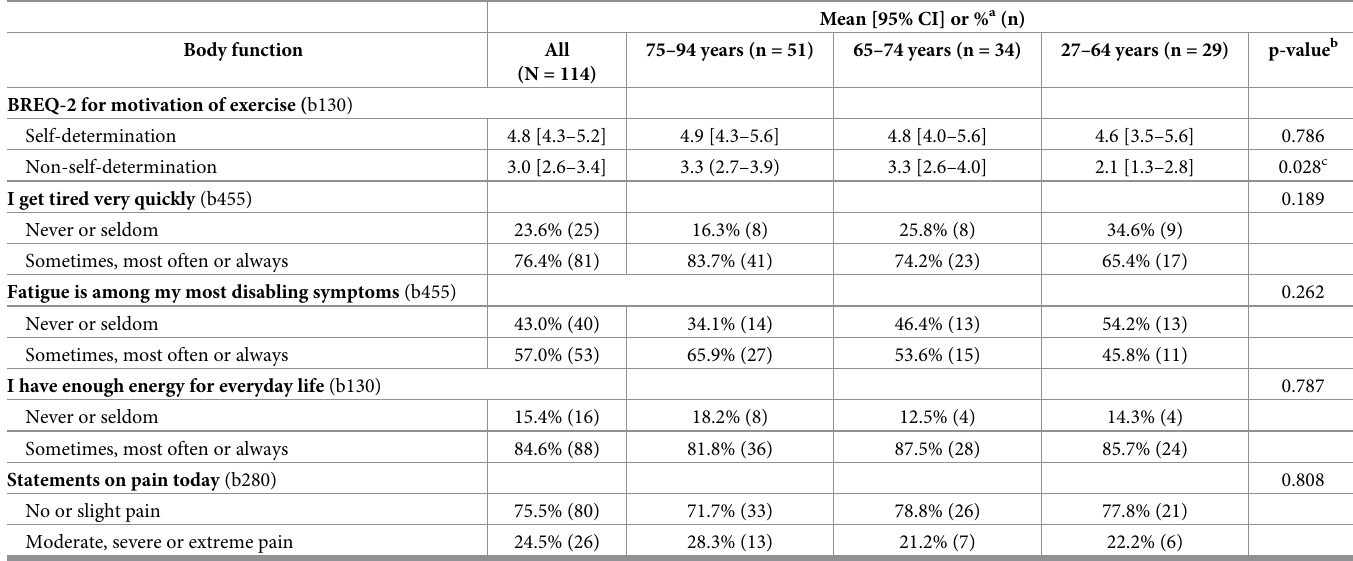
Table 3. Survey items linked to the ICF component of body